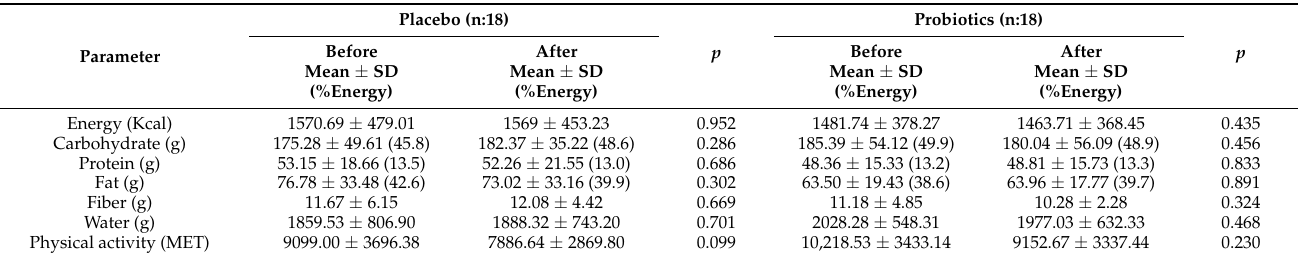
Table 6. Dietary intake and physical activity before and after intervention between